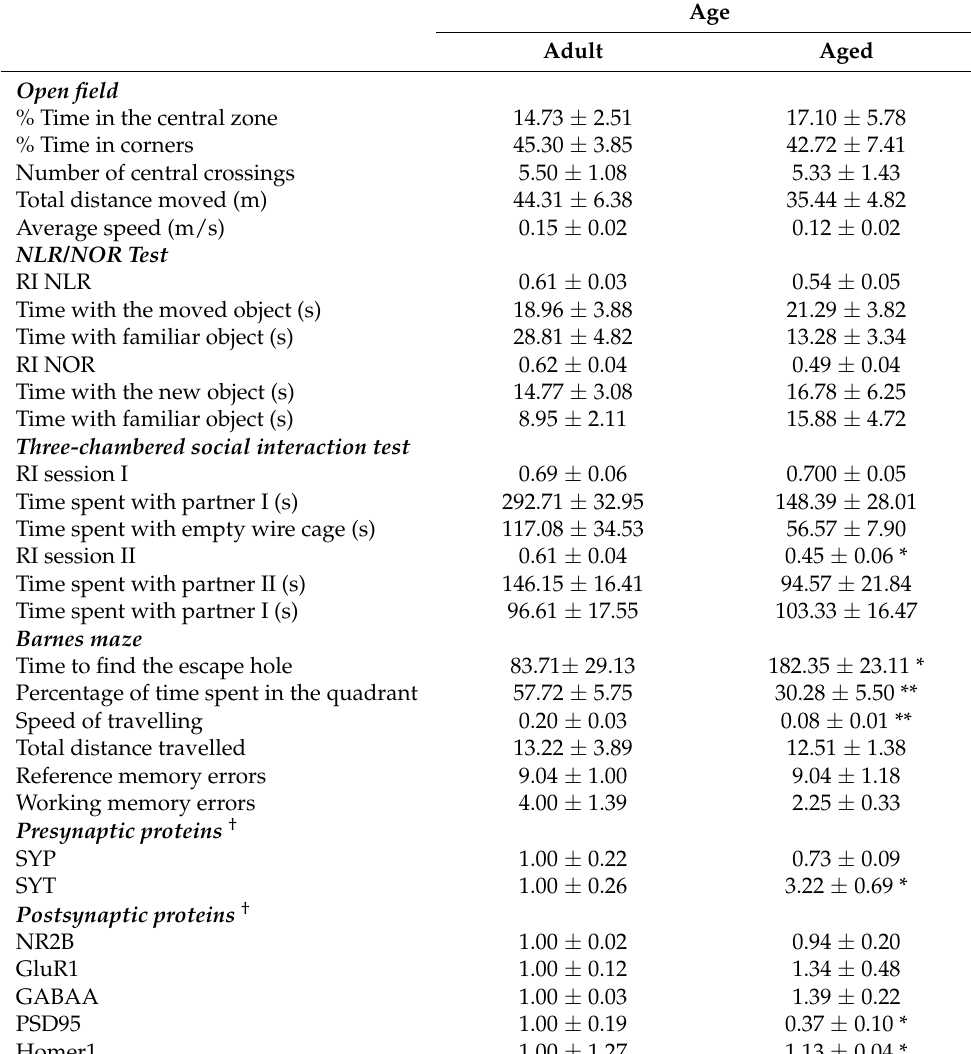
Table 1. Comparison of behavioral and molecular measurements between adult (36 months old) and aged (72 months old) control female